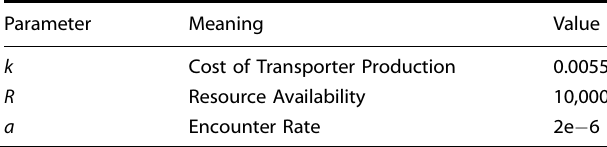
Table 1. Parameter values used in numerical